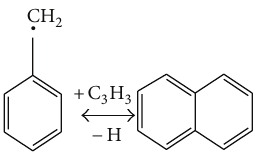
Figure 10: The polycondensation of